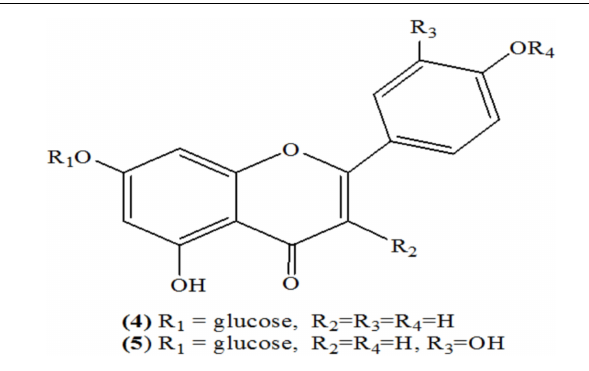
FIGURE 1 | Flavonoids. out of the fourteen were evaluated for anti-cancer activity against non-small cell lung cancer cells (NCI-H460). Fraction obtained at second position significantly decreased growth of cell with IC 50 value of 10 mg/ml concentration (Vanajothi and Srinivasan, 2015).